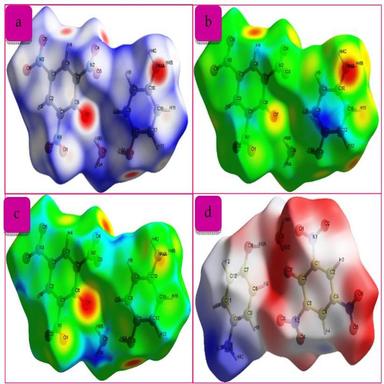
irshfeld surfaces of HAPH (a) dnorm (b) di (c) de (d) electrostatic potential (ESP) (Bright red area – dominant interactions Light color - weaker and longer contacts)